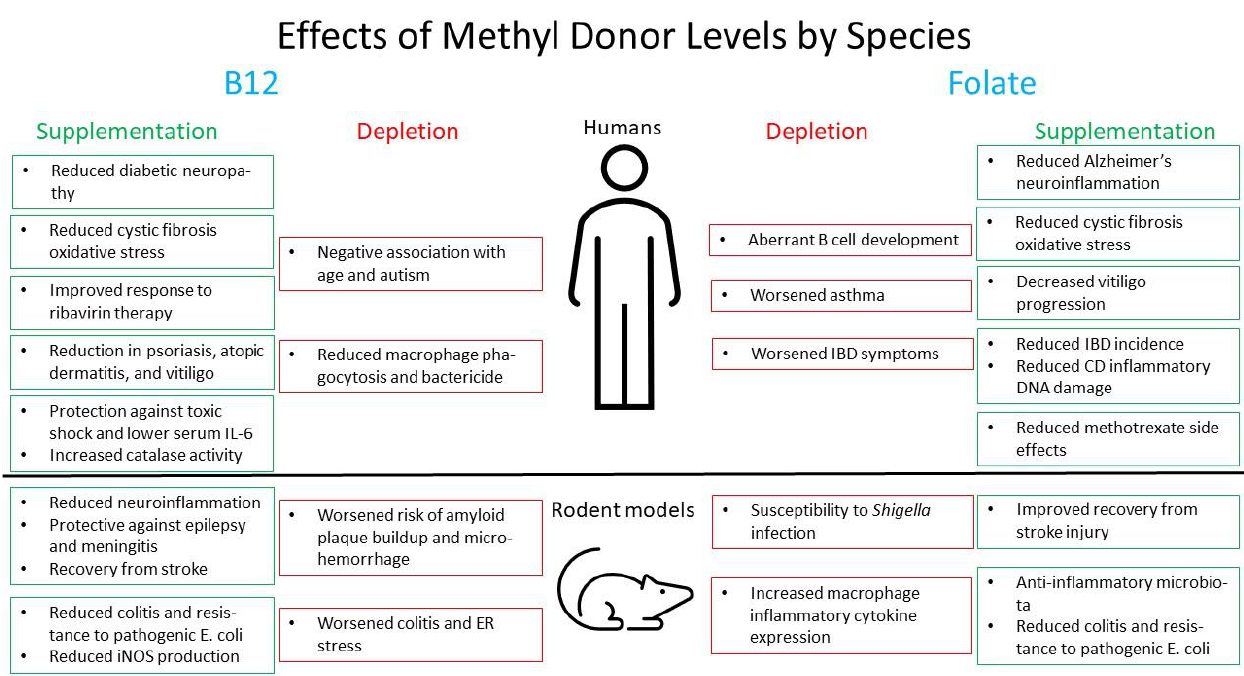
Figure 3. SAM and inflammation. Overview of the effects of SAM supplementation on the brain ( top left ), airways ( top right ), liver ( bottom left ), and spleen/vasculature ( bottom right ) ( A ). Possi-